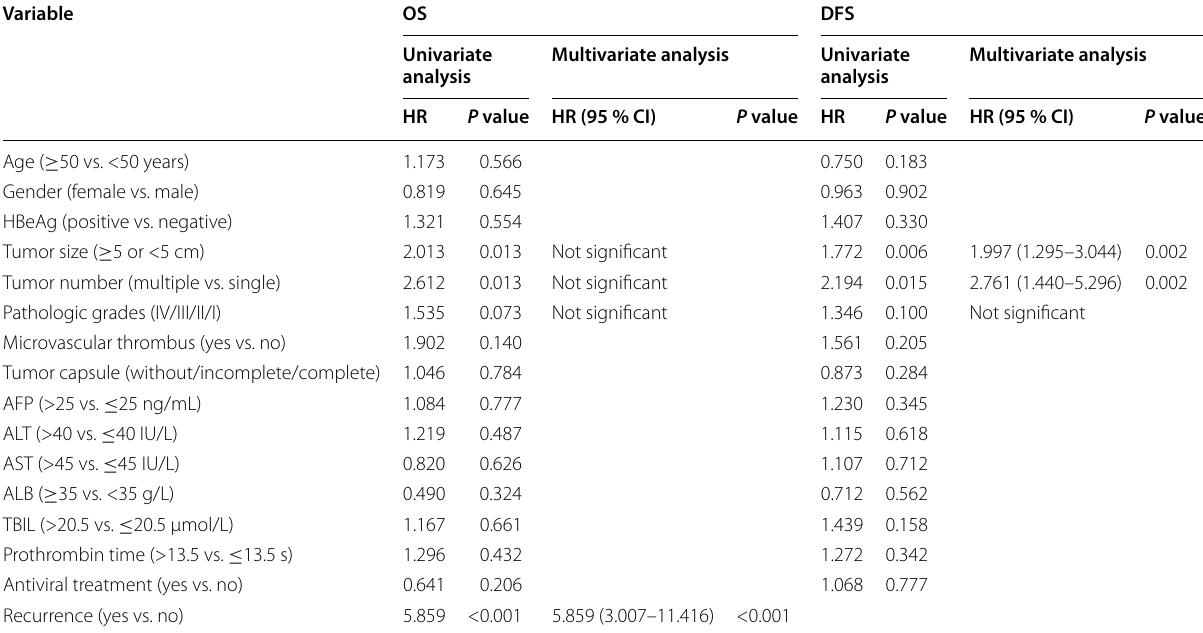
OS overall survival, DFS disease-free survival, CI confidence interval, HR hazard ratio, Antiviral group resection plus postsurgical antiviral treatment group, Non-antiviral group resection alone group, HBV hepatitis B virus, SD standard deviation, HBeAg hepatitis B e antigen, TNM tumor-node-metastasis, AFP alpha-fetoprotein, ALT alanine aminotransferase, AST aspartate aminotransferase, ALB serum albumin, TBIL serum total bilirubin